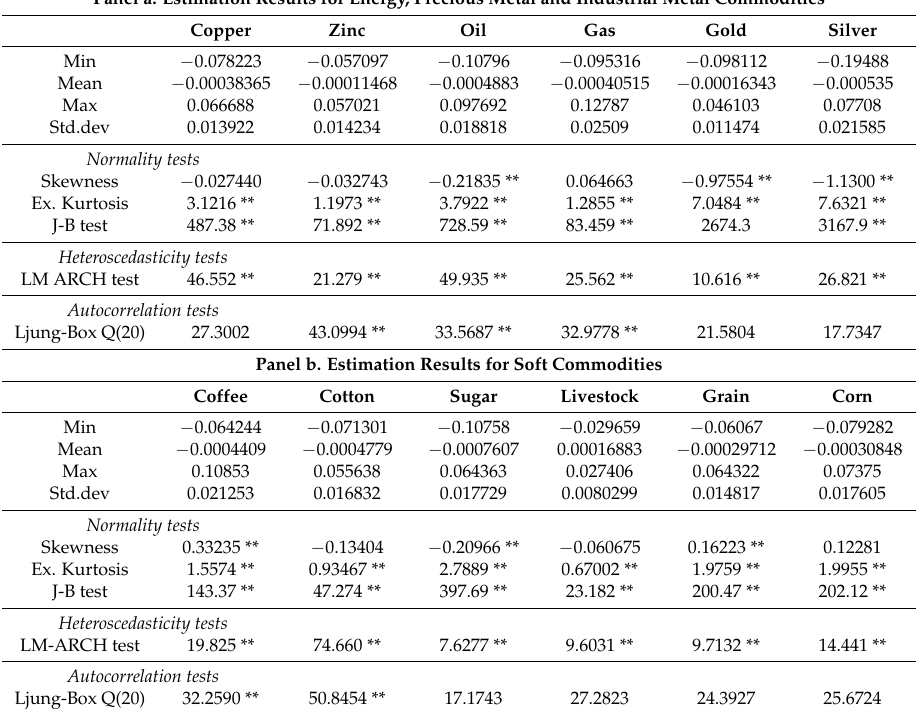
Table 2. Descriptive statistics of changes in the daily sukuk and commodity indices. Panel a. Estimation Results for Energy, Precious Metal and Industrial Metal